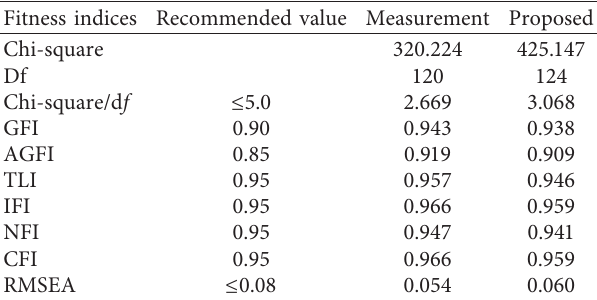
Table 5: Model fitness indices computed through